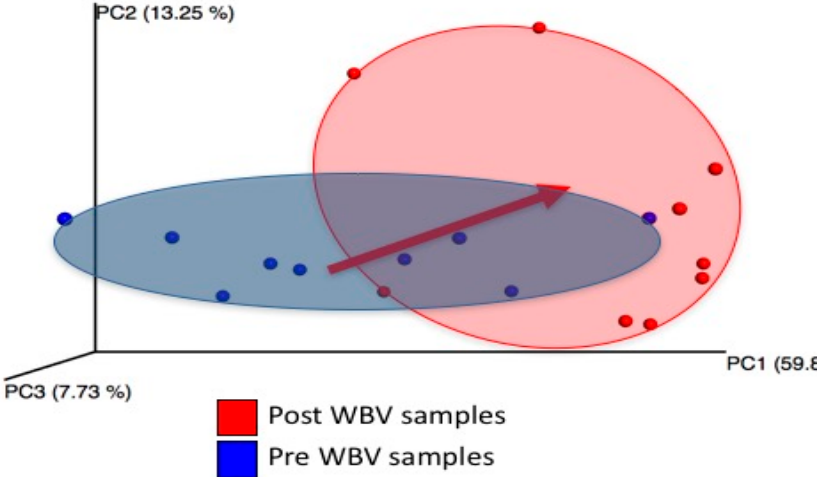
Figure 2. Changes in beta diversity (weighted UniFrac), due to WBV. Each point represents microbial community composition (weighted by species abundance) within an individual mouse. Distance between points indicates how similar microbial communities are between hosts and time points. Microbial composition shifts post WBV.